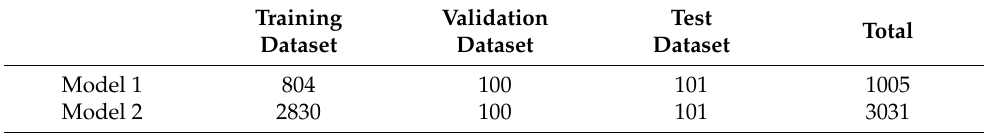
Table 1. Number of images for training, validation and test datasets.